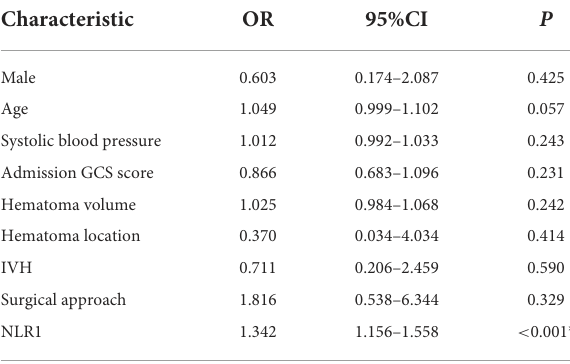
TABLE 2 The multivariate logistic regression analysis of variables associated with the 30-day poor